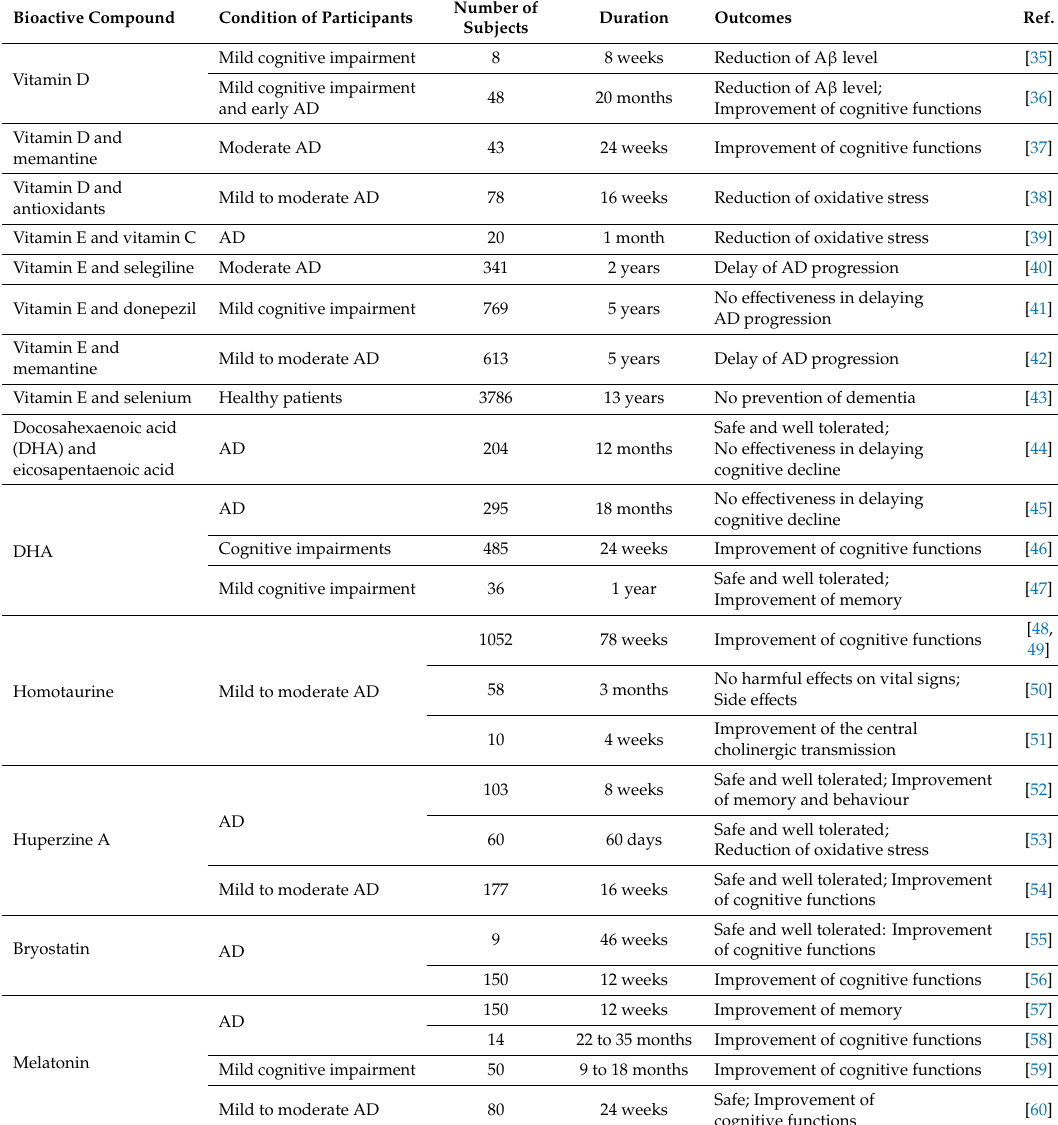
Table 1. Bioactive compounds in clinical trials for AD